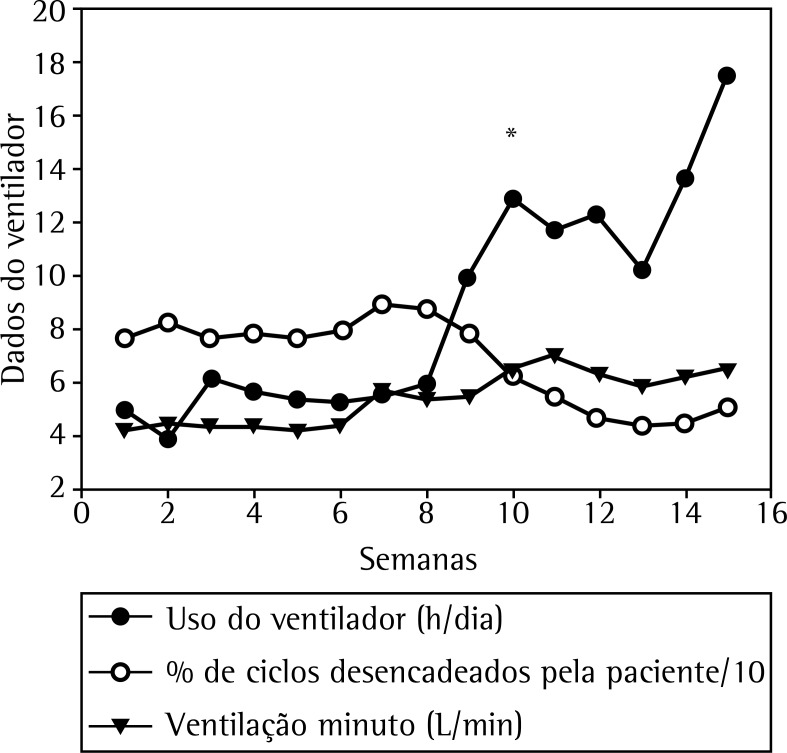
Dados do ventilador durante um período de 15 semanas em uma paciente com
esclerose lateral amiotrófica tratada com ventilação com dois níveis de
pressão positiva nas vias aéreas. Nota-se o aumento da duração do uso diário
de ventilação com a diminuição da capacidade de desencadear ciclos
respiratórios espontaneamente (isto é, o aumento da dependência dos ciclos
cronometrados gerados pelo ventilador) ao longo do tempo. Como se pode
observar, a ventilação minuto manteve-se relativamente constante. *O suporte
ventilatório aumentou entre a 8ª e a 9ª semana; a 10ª semana reflete esse
aumento pela primeira semana completa.